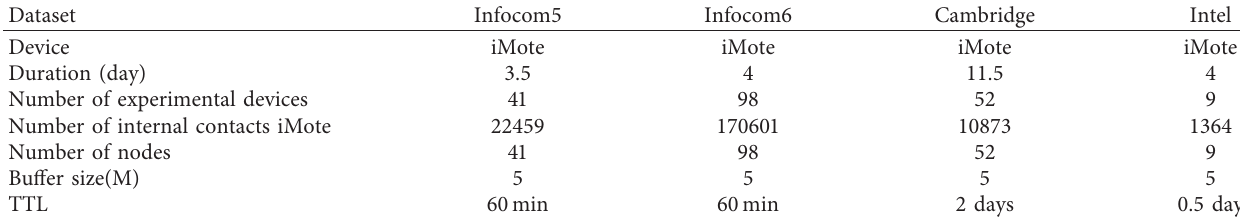
Table 3: The parameter settings for a specific simulation environment.